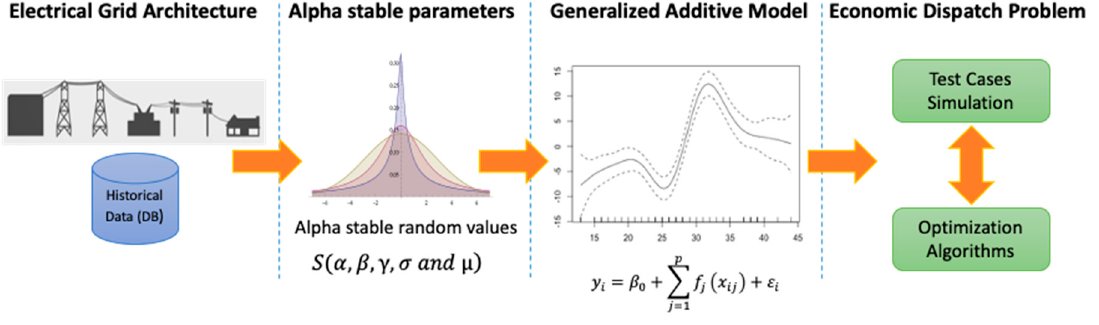
Figure 1. Proposed hybrid model.